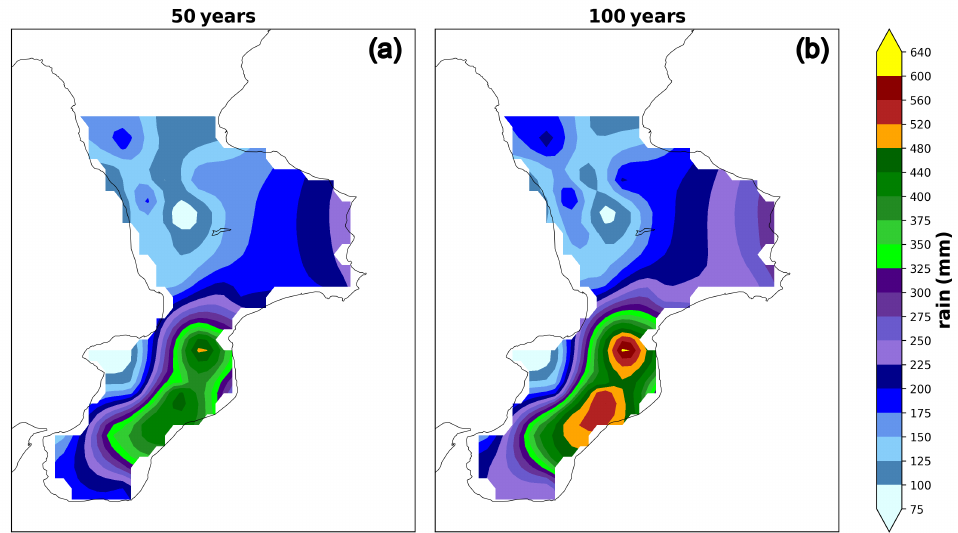
Figure 10. Return-level map of extreme rainfall for a fixed return period for all of the Calabria stations. Return-level map for a return period of 50 years ( a ) and 100 years ( b